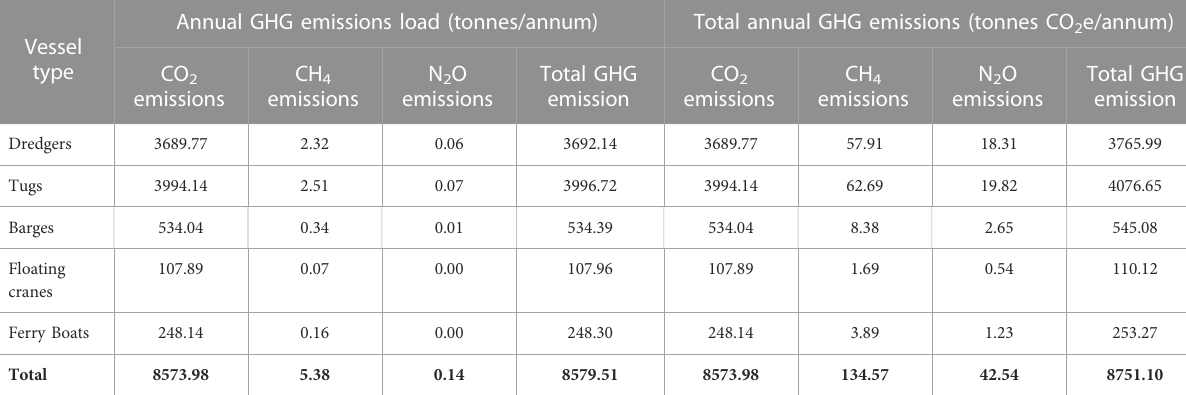
TABLE 12 Breakdown of total annual GHG emissions from harbour crafts of KPT.